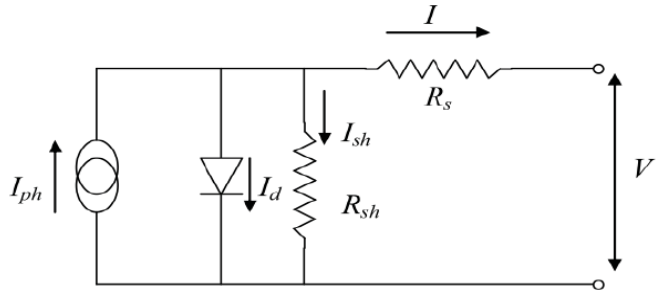
Figure 3. A standard PV cell scheme.